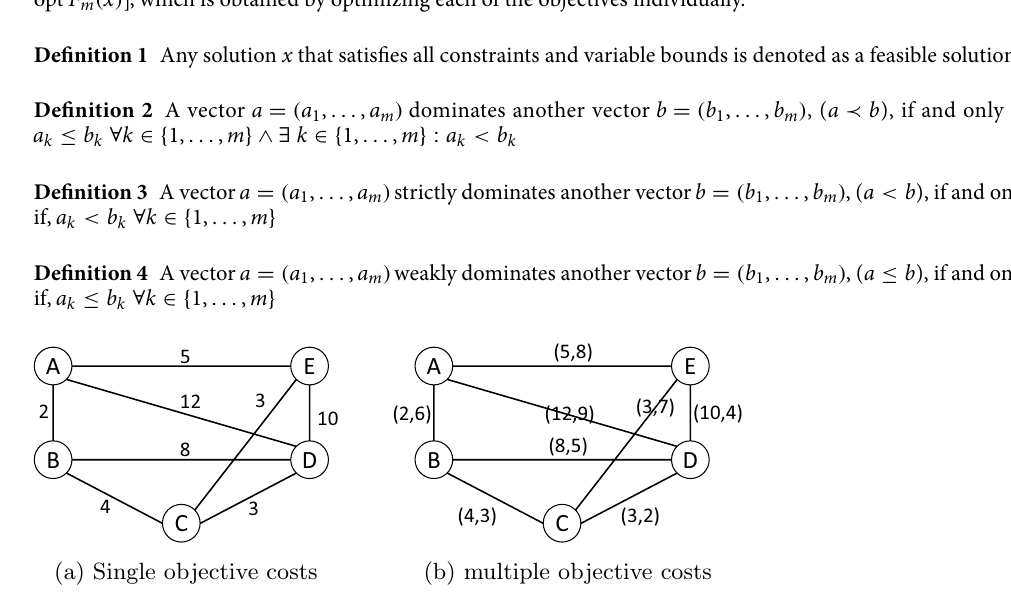
Figure 1. Illustration of single and bi-objective TSP